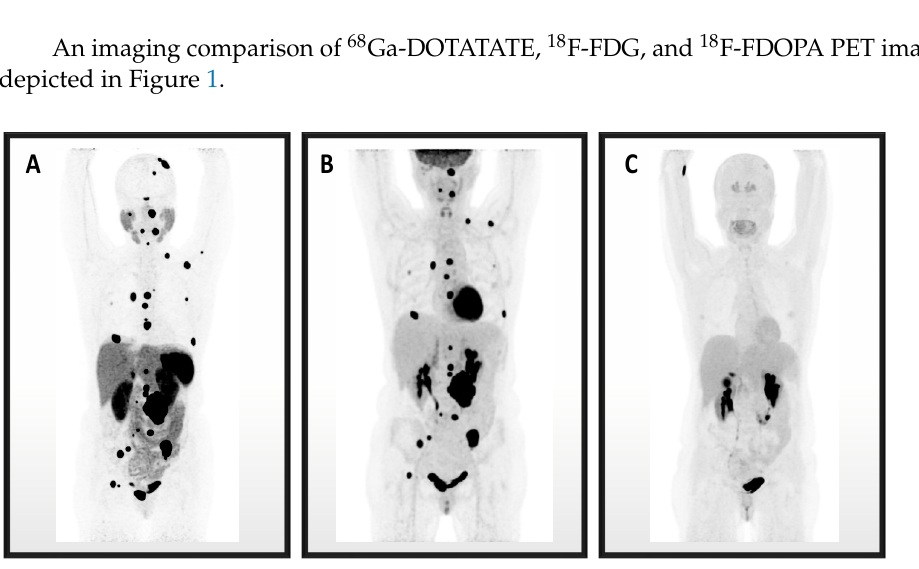
Figure 1. These are maximum intensity projection image PET/CTs for Patient 3. ( A ) 68 Ga-DOTATATE identified the most PPGL lesions, followed by ( B ) 18 F-FDG, and the fewest lesions were identified on ( C ) 18